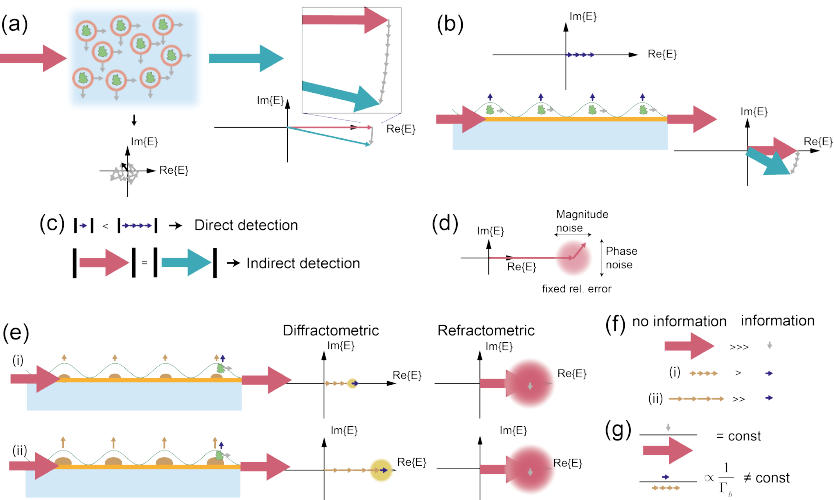
Figure 6. Fundamental differences in interferometric refractometric and diffractometric detection of biomolecular binding and their implications on readout precision: ( a ) a dilute ensemble of biomolecules is illuminated by coherent light. The molecules scatter light in all directions. In the for- ward direction, the interference between the incident and scattered fields results in phase retardation of the incident phasor (refraction). In off-axis directions, the scattered phasor is a random phasor sum, and most importantly, the main beam does not interfere with the scattered phasors. ( b ) Molecules on a substrate are arranged such that their scattered fields interfere constructively in the direction of the surface normal (diffraction). The length of the individual phasors add up and fully contribute to the resultant phasor. The effect in the forward direction is still only a rotation of the incident phasor with no magnitude change. ( c ) For off-axis detection (diffraction), the length of the resultant depends on the amount of molecules. This allows for direct detection methods. For forward detection (refraction), the length of the resultant phasor is not changed and hence can only be detected with indirect methods (homodyne and heterodyne detection) that supply a phase reference. ( d ) Every phasor that can interfere at the detector can only be stabilized/measured to/with a certain precision. This leads to an uncertainty in magnitude and phase of the phasor. ( e ) (i) A surface-based biosensor with a low bias (yellow) and the effect of one additional molecule (green) that binds to it: The diffractometric as well as the refractometric sensor responses have an uncertainty that is proportional to the length of the phasor that hits the detector before the measurement. Since the refractometric response includes the incident (strong) beam, the small scattering phasor due to the molecule cannot be detected. This is possible in the diffractometric response because the already diffracted power is comparable to the magnitude of the additional phasor. (ii) The same sensor with a larger bias (higher diffraction efficiency): while the relative uncertainty remains constant, the absolute value increases. If the relative measurement precision is the same as before, the diffractometric sensor can no longer detect binding of the molecule. ( f ) The information content of the electromagnetic fields is another way to explain the higher relative measurement precision requirements of refractometric sensors. In refractometric sensors, the large incident phasor does not contain any information of the binding event. Only the small grey phasor contains binding information. In contrast, the information content of diffractometric biosensors is much higher as long as the diffracted phasor before the molecule binds is not too large. ( g ) The information content about the binding event for given refractometric sensors is always constant. For a diffractometric biosensor, it is inversely proportional to the coherent mass that is already on the